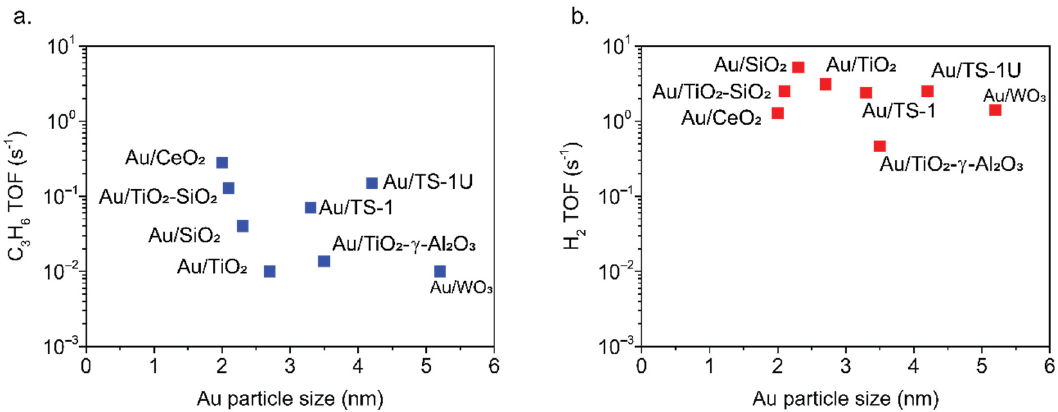
Figure 4. Specific activity for the oxidation of propene and the conversion of hydrogen over supported gold catalysts. ( a ) Activity (TOF) for C 3 H 6 oxidation ( b ) activity (TOF) for H 2 oxidation. Conditions: 150 mg of catalyst, 10,000 mL/g cat /h flow of 10% of each C 3 H 6 , O 2 and H 2 in He at 200 °C. Only 25 mg of catalyst was used in the case of Au/CeO 2 .